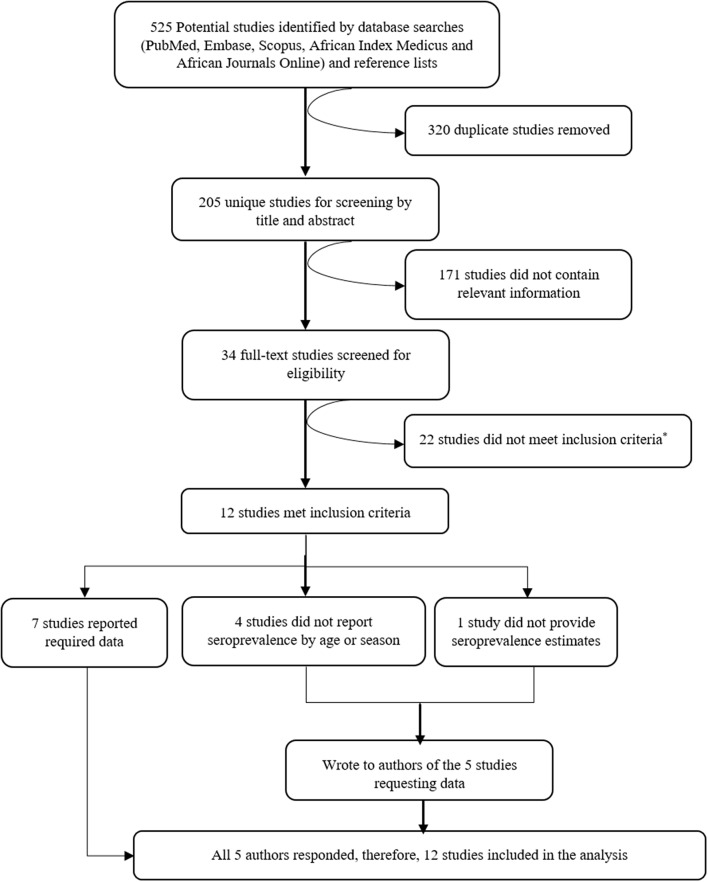
Consort diagram showing the selection of studies to include in the systematic review and meta-analysis. Reasons for exclusion are included at each step. *Reasons for exclusion: six studies measured immune responses semi-quantitatively (four of these in the same population), 11 studies had a sample size of < 30, five studies were healthcare facility-based studies (i.e., primary care facilities or hospitals).